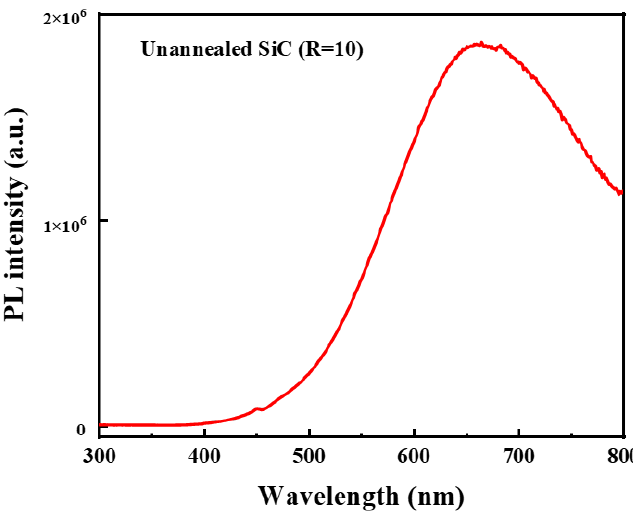
Figure 3. PL spectrum of the un-annealed SiC (R =